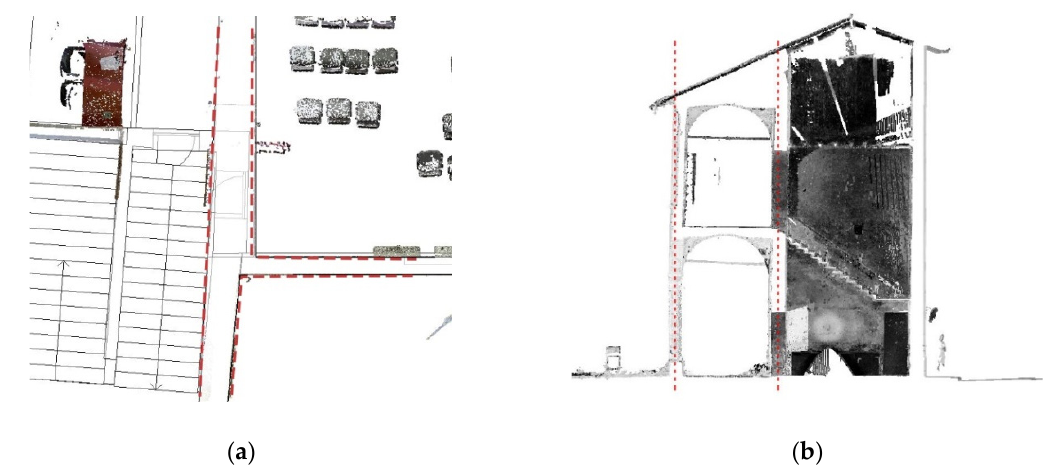
Figure 1. ( a ) A not perpendicular junction between three not regular walls in P. Trivulzio; ( b ) Section of the former Corpus Domini Monastery with tapered masonries.